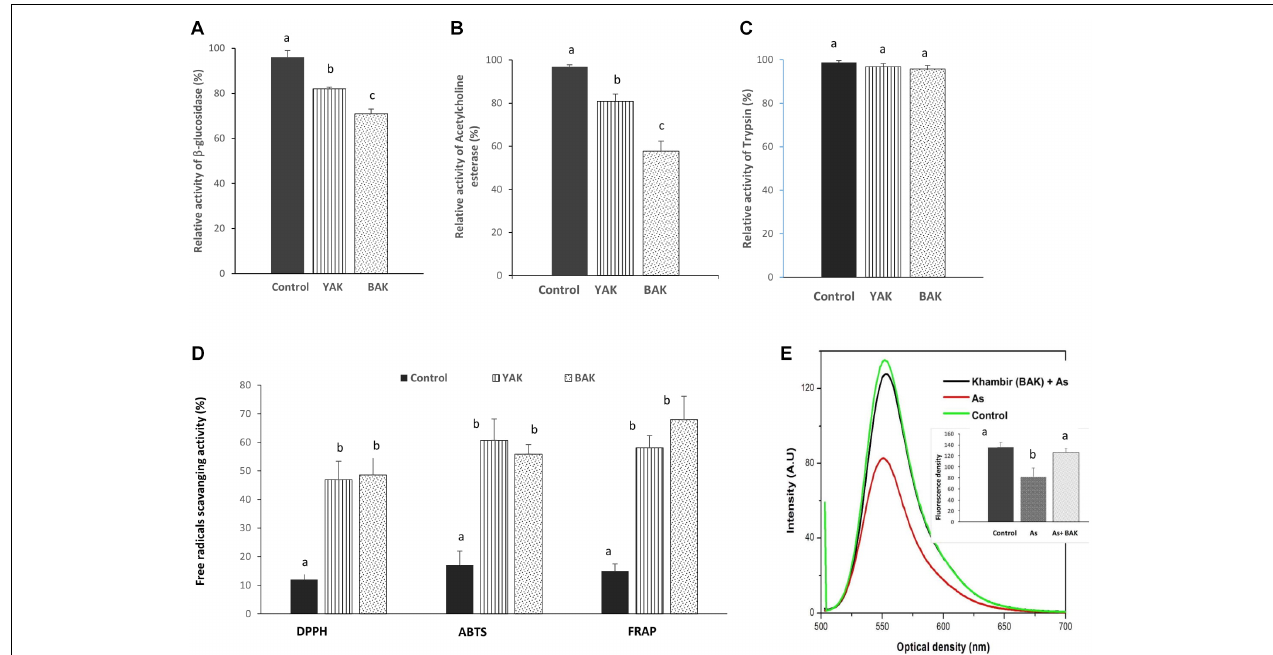
FIGURE 2 | | Evaluation of bioactivities of aqueous extract of yeast added khambir (YAK) and buttermilk added khambir (BAK). Changes of β -glucosidase (A) , acetylcholine esterase (B) , trypsin (C) inhibitory activities, and in vitro antioxidant (D) activities (DPPH, ABTS, FRAP) of fermented khambir , i.e., YAK and BAK in respect to control (unfermented) were determined. The activity of enzymes (without any additive) was considered as 100%. (E) The alteration of mitochondrial transmembrane potential in respect to emitted fluorescence level of Rhodamine 123 during exposure of arsenic and arsenic + khambir extract (BAK) in in situ intestinal loop model study. The control is indicated the fluorescence intensity of control tissue. Data presented as the mean ± standard deviation of five replicates. Different superscripts (alphabet) on the bar indicated the level of significance difference ( p < 0.05) among respective groups.